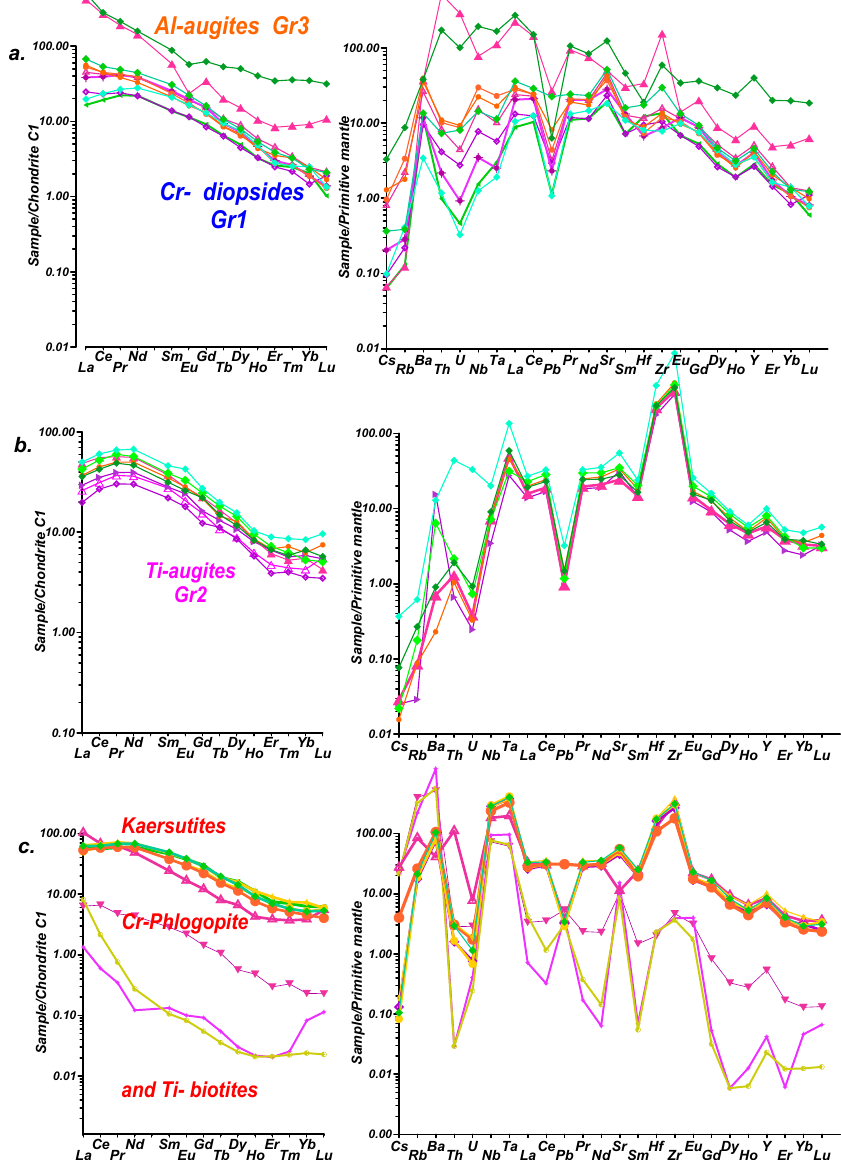
Figure 18. REE patterns and TRE spider diagrams of minerals of aillikites of Yuzhnaya pipe: for Cr-diopsides and Al-augites ( a ); for Ti-augites ( b ) for kaersutites and Ti biotites ( c ). Normalized to primitive mantle [61] and chondrite C1 [68].